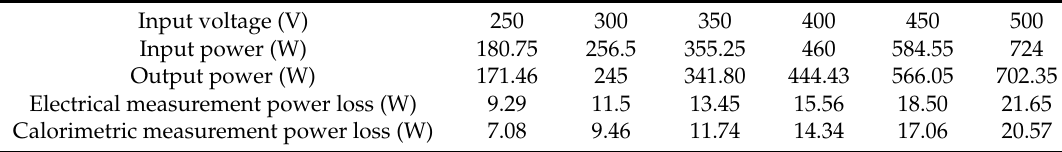
Table 4. Electrical loss measurement results under different bus voltages.